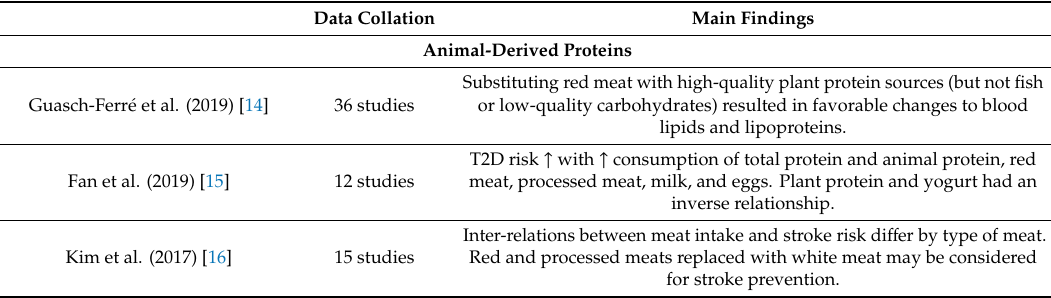
Table 1. Key systematic reviews and meta-analysis papers investigating animal, plant or fungal proteins and